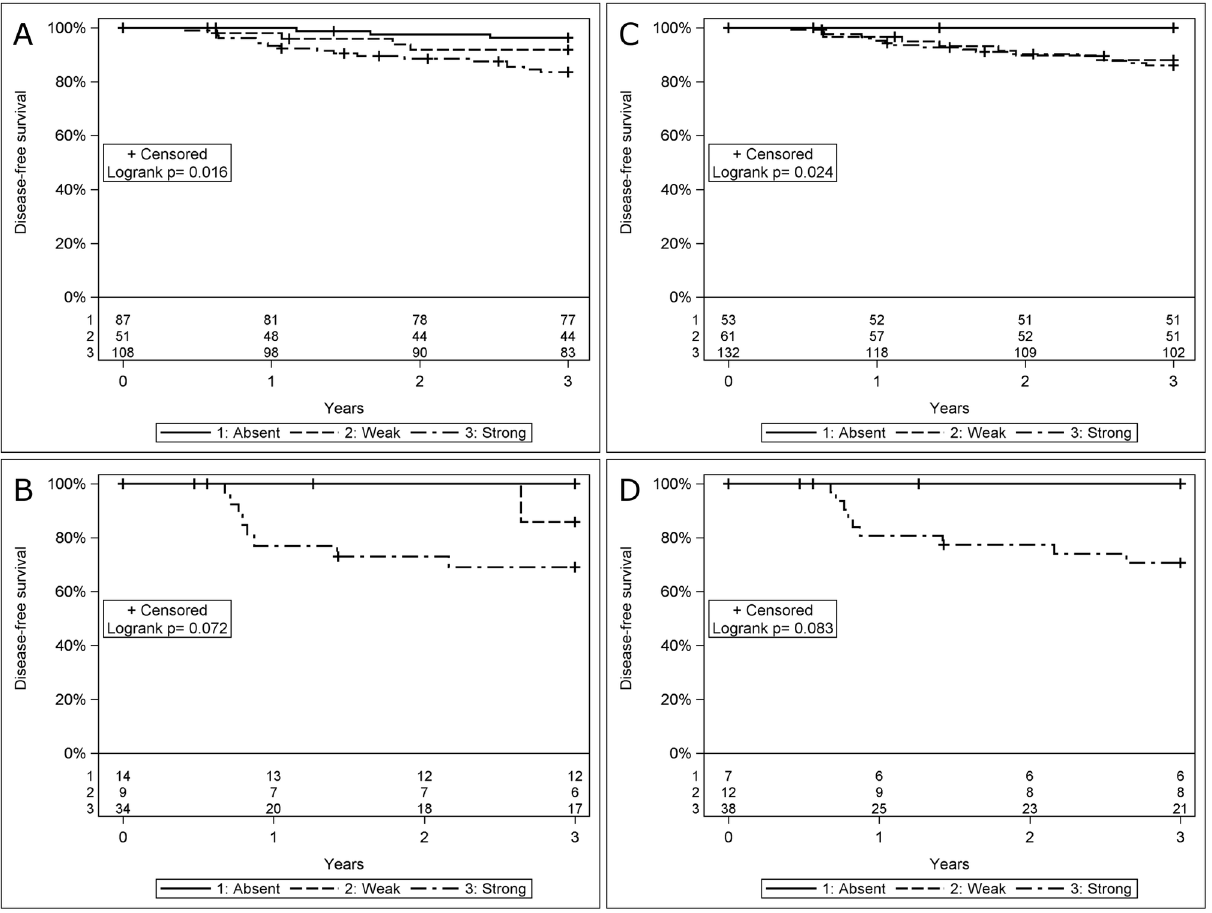
Figure 3. Survival presented with Kaplan-Meier curves, and analyzed using the logrank test, for disease-free survival (DFS), in patients with HPV-positive (HPV +) and p16 INK4a positive/negative oropharyngeal squamous cell carcinoma DNA (OSCC). (A) DFS in HPV + p16 INK4a positive OSCC stratified for HCA-2 intensity (p=0.016), (B) DFS in HPV DNA OSCC stratified for HCA-2 intensity (p=0.072), (C) DFS in HPV + p16 INK4a positive OSCC stratified for HC-10 intensity (p=0.024), DNA (D) DFS in HPV + p16 INK4a negative OSCC stratified for HC-10 intensity (p=0.083). DNA